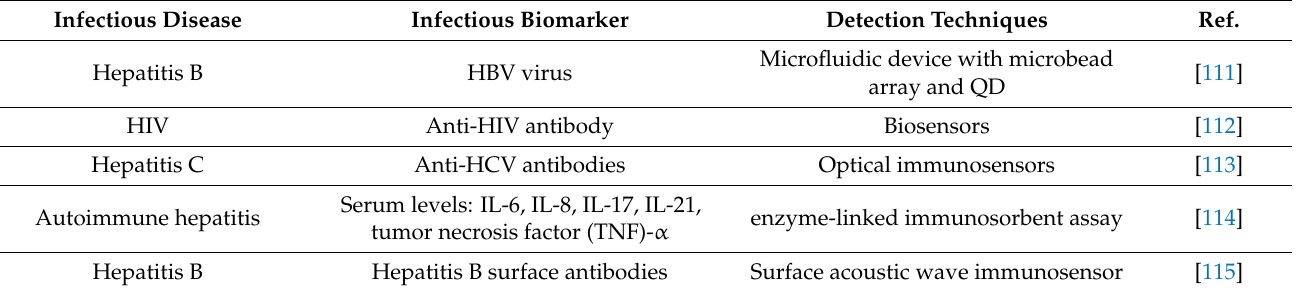
Table 3. QD-based biomarkers that are made to detect biomarkers of infectious